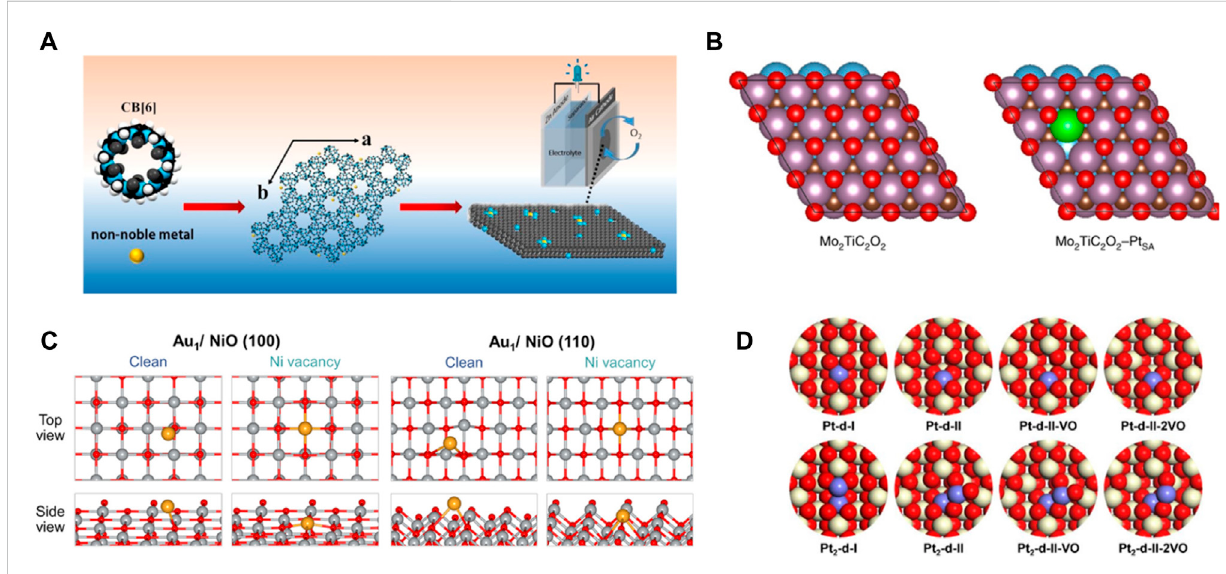
FIGURE 1 | The interaction of metals with different supported materials. (A) Schematic diagram of non-noble metal atom mixed with CB (He et al., 2020a) for ORR electrocatalysis. (Figure used with permission from Cao et al., 2021) (B) Top view of Mo 2 TiC 2 O 2 and Mo 2 TiC 2 O 2 -Pt SA catalyst con fi gurations. Color codes: Ti, blue; Mo, purple; Pt, green; C, brown; O, red. (Figure used with permission from Wang et al., 2018) (C) Geometry of Au single atoms deposited oncleananddefectiveNiO(100)orNiO(110)planes.Gray,RedandYellowrepresentNi,O,Auatoms,respectively.(Figureusedwithpermissionfrom Murayama et al., 2022) (D) Local structure of Pt atoms doped into CeO 2 (110). White, blue, Red and lattice represent Ce, O, Pt atoms, respectively. (Figure used with permission from Su et al.,